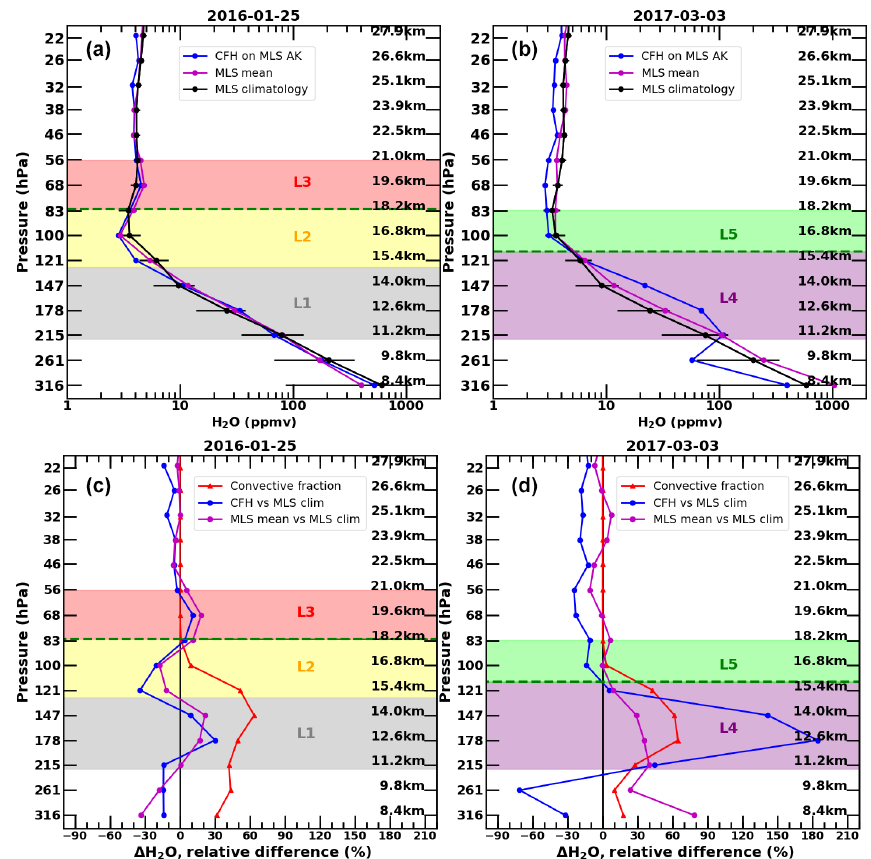
Figure 9. (a, b) Convolved CFH water vapor profiles (blue line), mean of closest-matched MLS profiles (magenta) and monthly mean climatological MLS water vapor profile for Réunion Island (black line; see text for definition of the MLS climatological profile) on 25 Jan- uary 2016 (a) and 3 March 2017 (b) . The horizontal bars in black correspond to the ± 1 standard deviation range. (c, d) Relative differ- ence between the convolved CFH water vapor profile and the MLS climatological profile for Réunion Island (blue line) and the mean of closest-matched MLS profiles and the MLS climatological profile (magenta line). The convective fraction computed with FLEXPART back trajectories and Meteosat-7 infrared brightness temperature is shown in red. Corresponding altitude values for MLS pressure levels are also shown in each